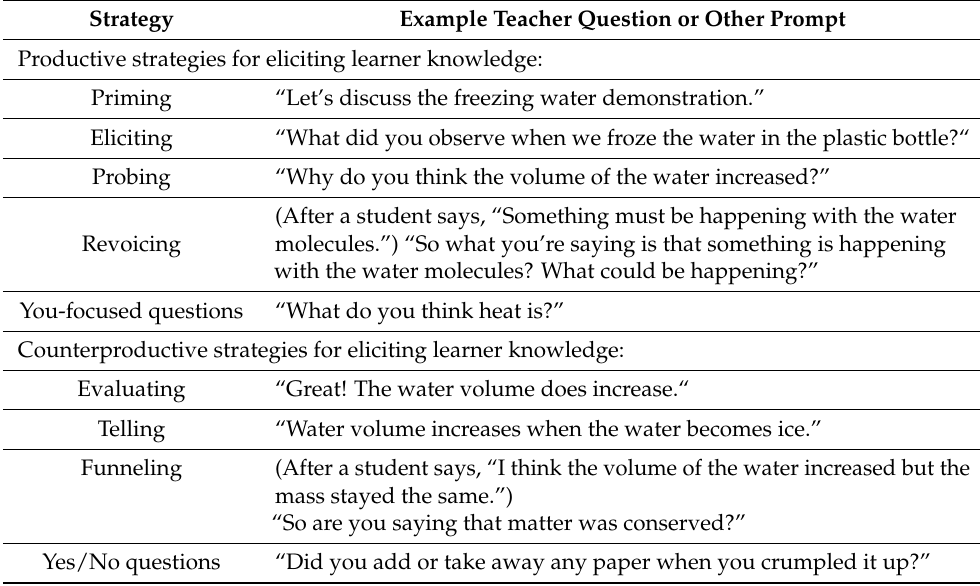
Table 3. Productive and unproductive strategies for eliciting learner